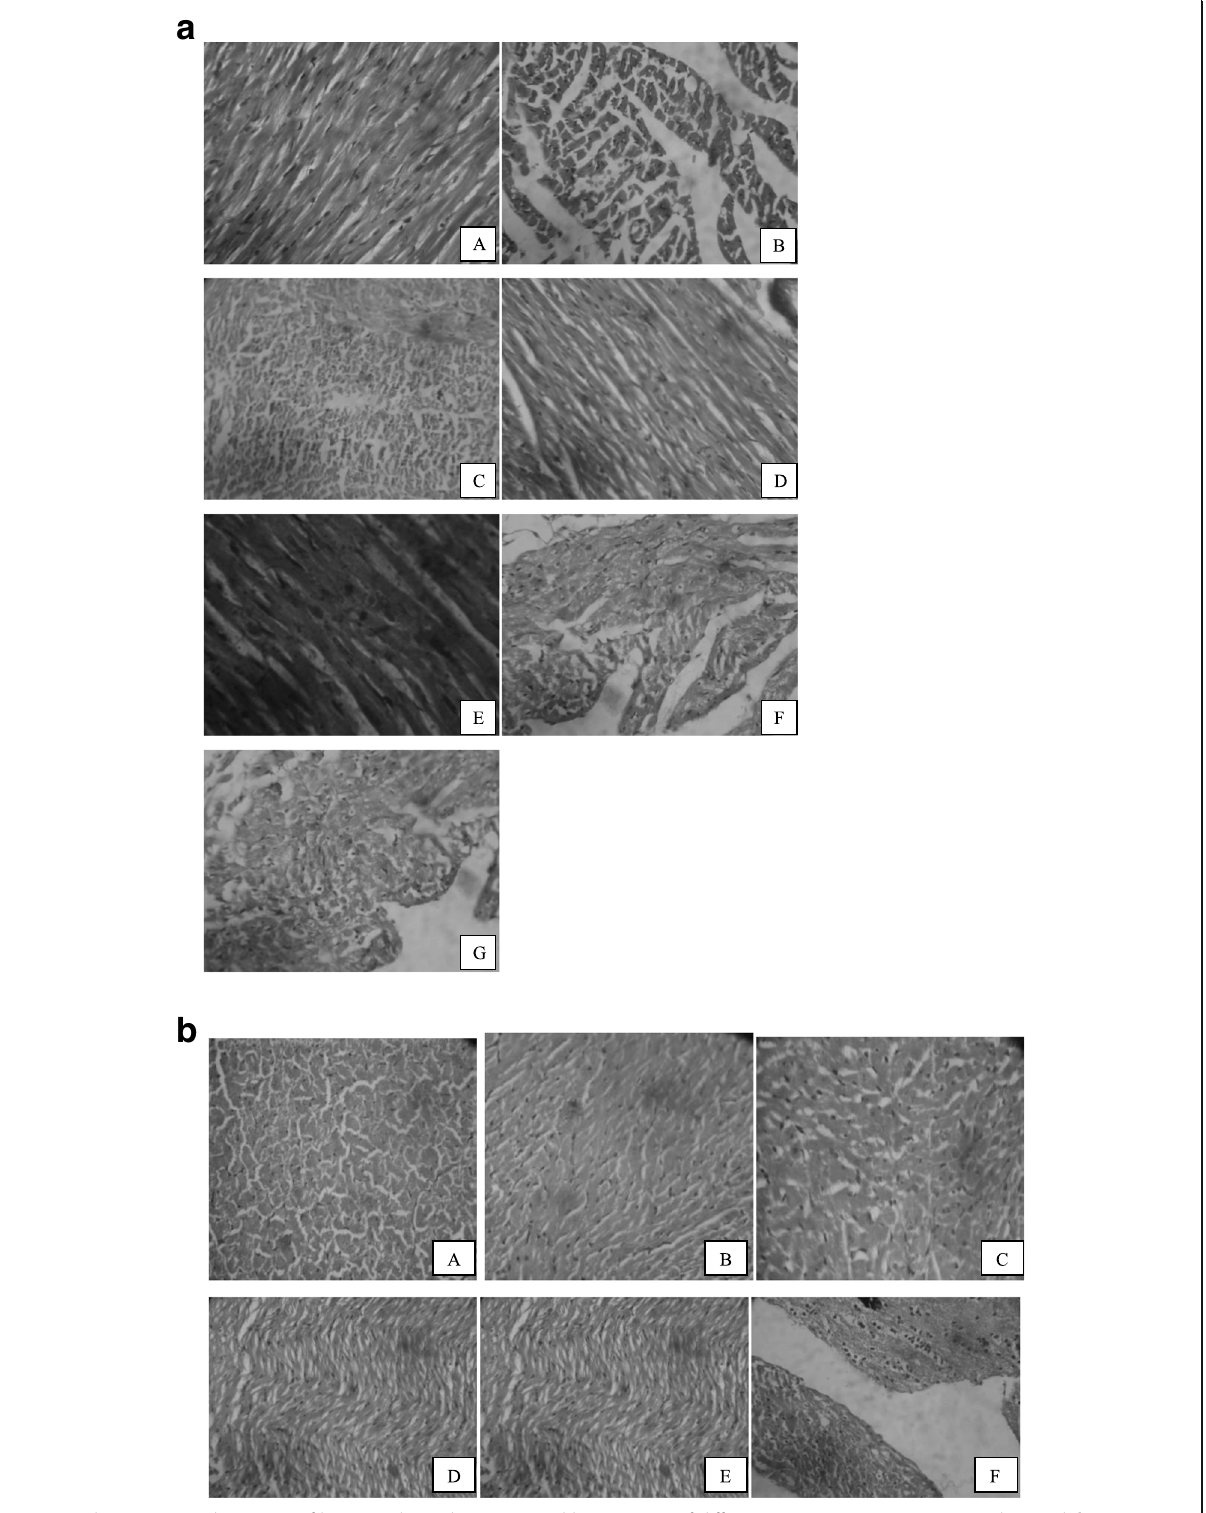
Fig. 5 a Photomicrographs (× 400) of hematoxylin and eosin stained heart tissues of different treatment groups: ( a ) normal control ( b ) ISO control ( c ) DTZ ( d ) STV 100 ( e ) STV 200 ( f ) STV 100 + DTZ ( g ) STV 100 + DTZ. b Photomicrographs (× 400) of hematoxylin and eosin stained heart tissues of different treatment groups: ( a ) IRI control ( b ) DTZ ( c ) STV 100 ( d ) STV 200 ( e ) STV 100 + DTZ ( f ) STV 100 +